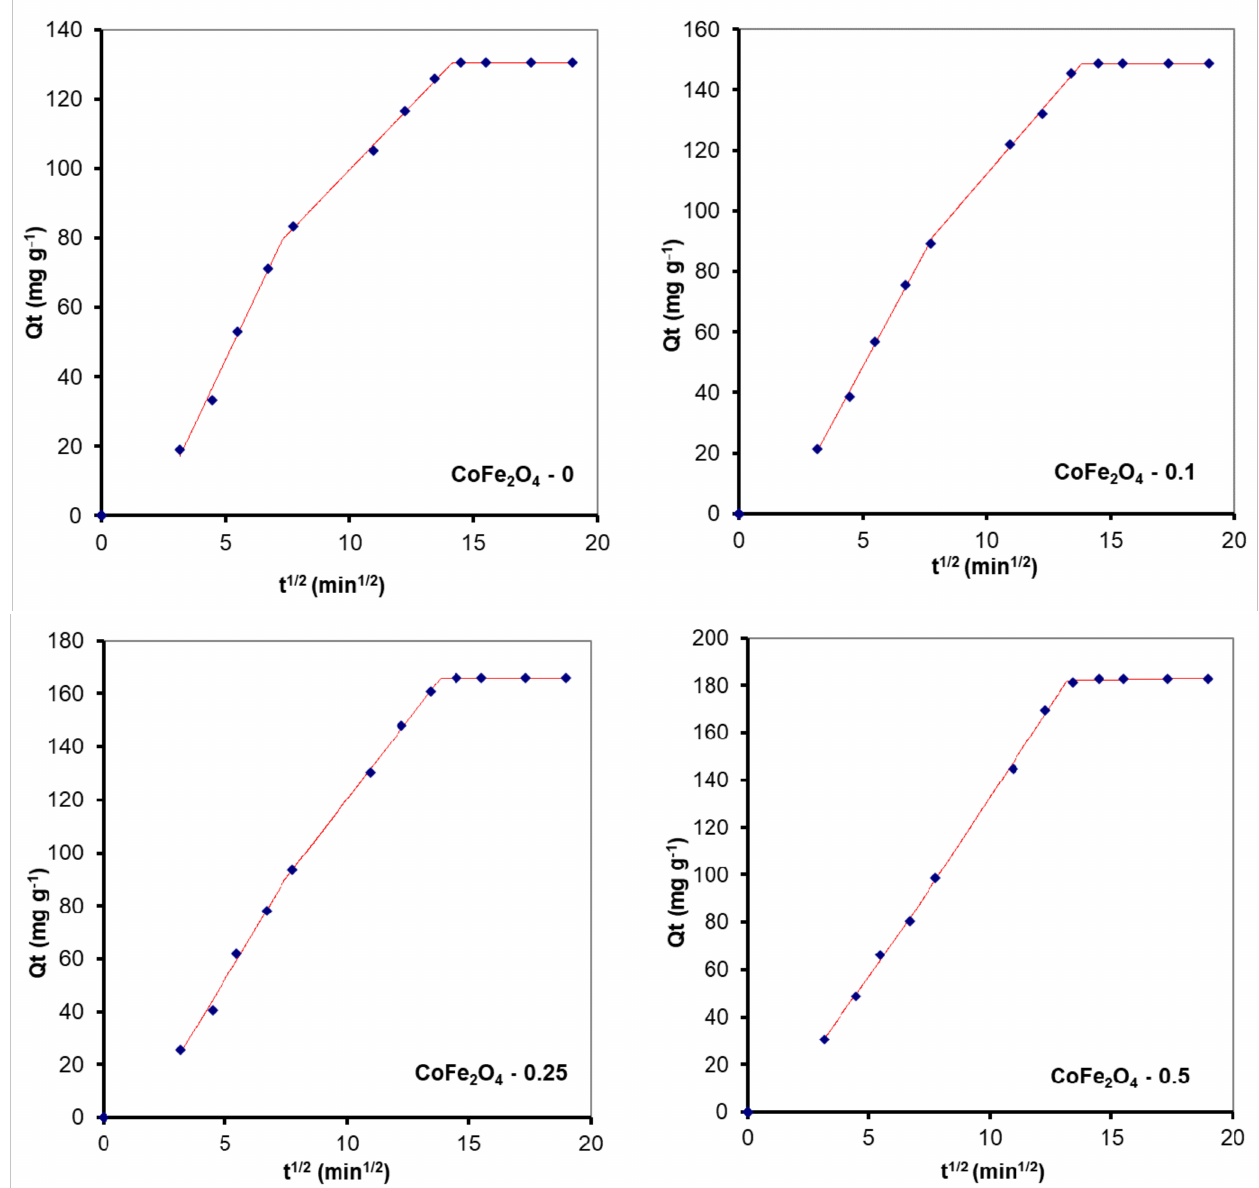
Figure 16. Kinetic modelling of the experimental data obtained from the sorption process of CR onto CoFe 2 O 4 samples using the intraparticle diffusion